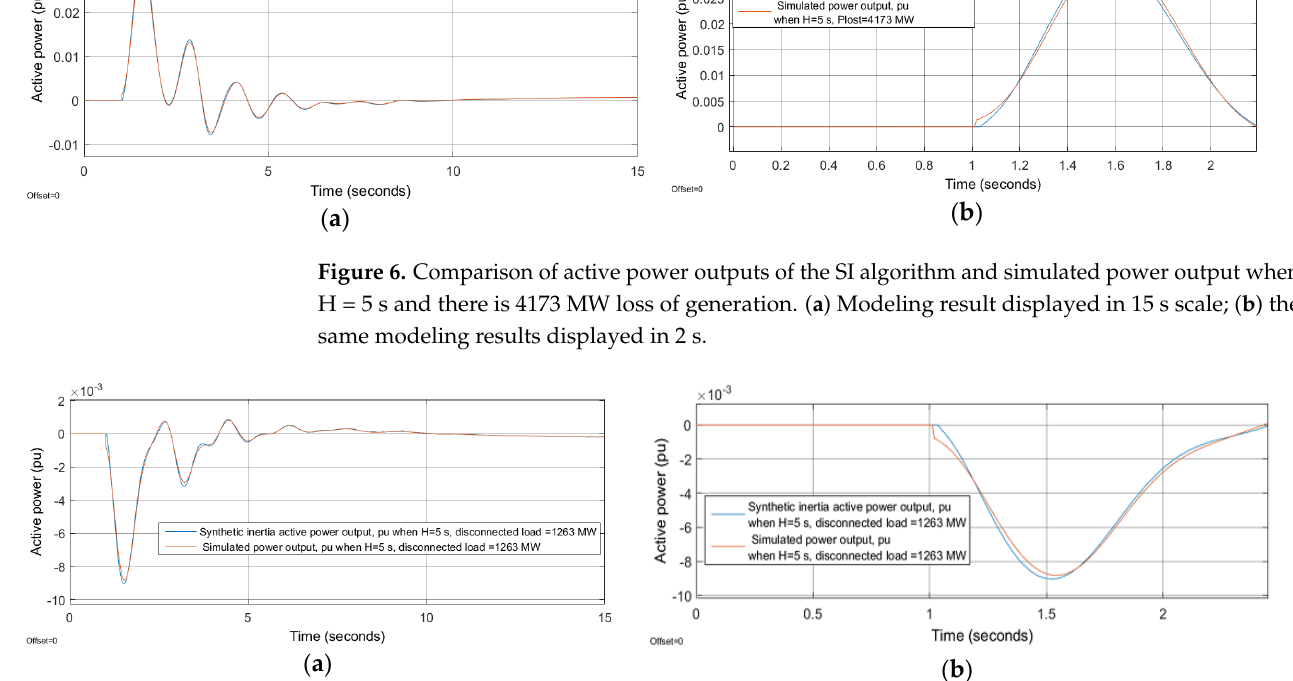
Figure 7. Comparison of active power outputs of SI algorithm and simulated power output when H = 5 s and there is 1263 MW disconnected load. ( a ) Modeling result displayed in 15 s scale; ( b ) the same modeling results displayed in 2 s.